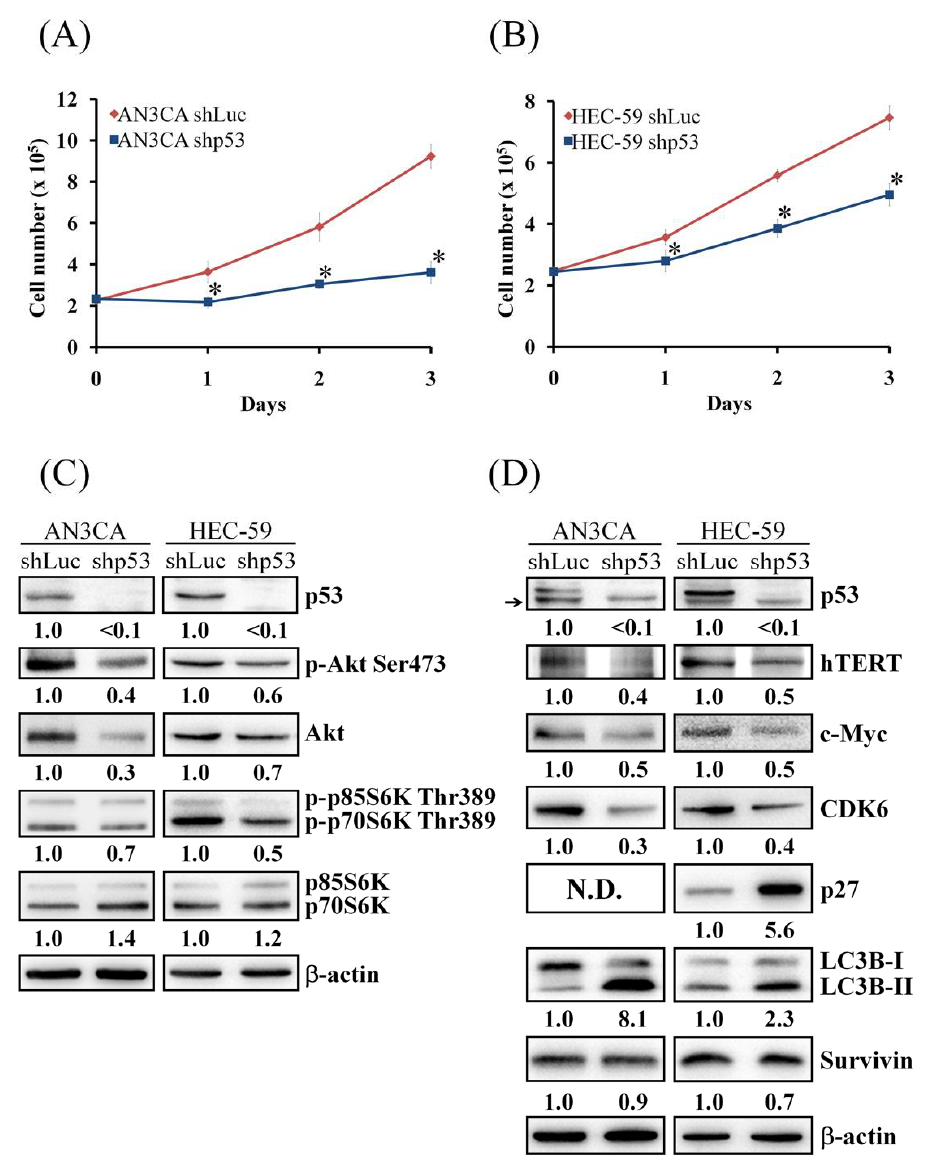
Figure 6. Effect of mtp53 knockdown on cell proliferation and Akt/mTOR pathway. ( A ) AN3CA shLuc and shp53 cells (2 × 10 5 cells/35 mm dish) were seeded on a 35 mm dish. After 24 (Day 0), 48 (Day 1), 72 (Day 2), and 96 h (Day 3) incubation, the cells were harvested by trypsin and counted under an inverted microscope. ( B ) HEC-59 shLuc and shp53 cells (2.5 × 10 5 cells/35 mm dish) were seeded on a 35 mm dish. After 24 (Day 0), 48 (Day 1), 72 (Day 2), and 96 h (Day 3) incubation, the cells were harvested by trypsin and counted under an inverted microscope. ( C ) Protein expressions of p53, p-Akt, Akt, p-p85S6K/p70S6K, and p85S6K/p70S6K were determined by Western blot. ImageJ software was used to quantify the band intensities of p53, p-Akt, Akt, p-p85S6K/p70S6K, and p85S6K/p70S6K. Data shown are the relative expression standardized by the β -actin protein level. The ratio of shLuc cells was set at 1. ( D ) Protein expressions of p53, hTERT, c-Myc, CDK6, p27, LC3B, and survivin were determined by Western blot. The arrow indicated the nonspecific band. ImageJ software was used to quantify the band intensities of indicated protein. Data shown are the relative expression standardized by the β -actin protein level. The ratio of shLuc cells was set at 1. The symbol ∗ indicates p < 0.05. N.D., not